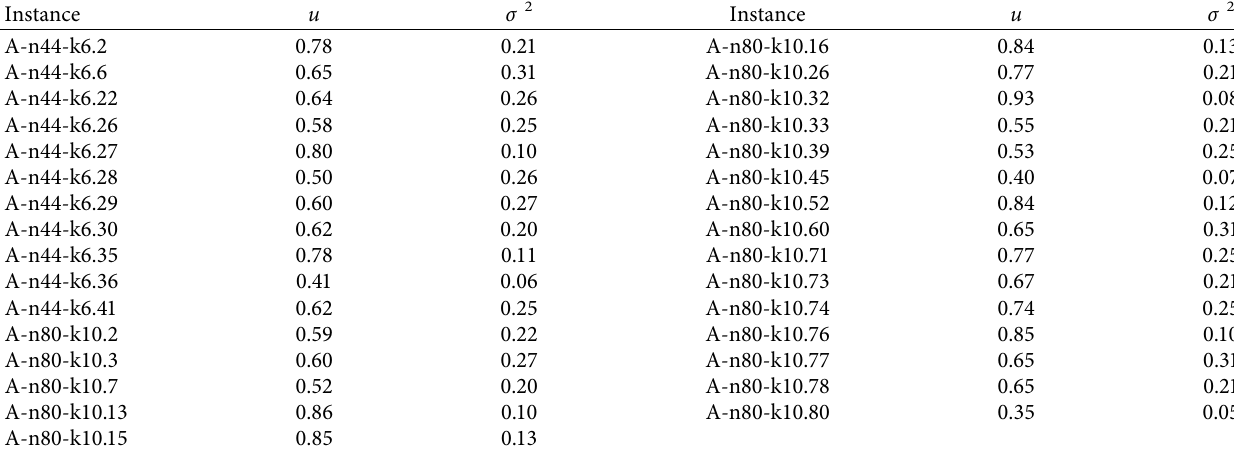
Table 1: Mean and variance of some customer points.